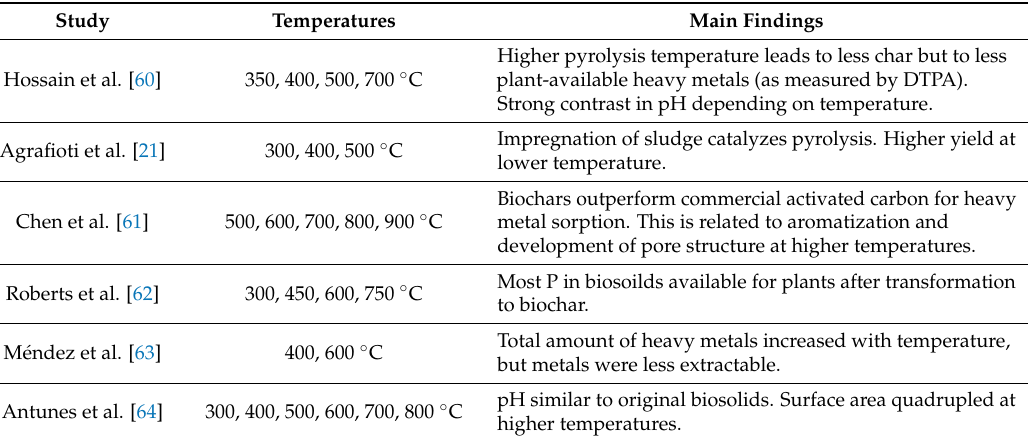
Table 3. Main findings with respect to the physico-chemical characteristics of biochars derived from